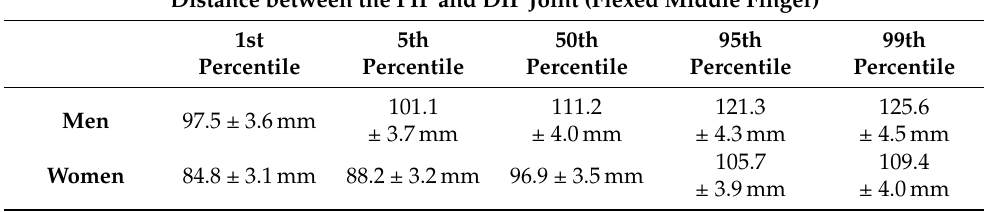
Table A6. Distance between the Proximal Interphalangeal (PIP) and Distal Interphalangeal (DIP) joint with flexed middle finger.